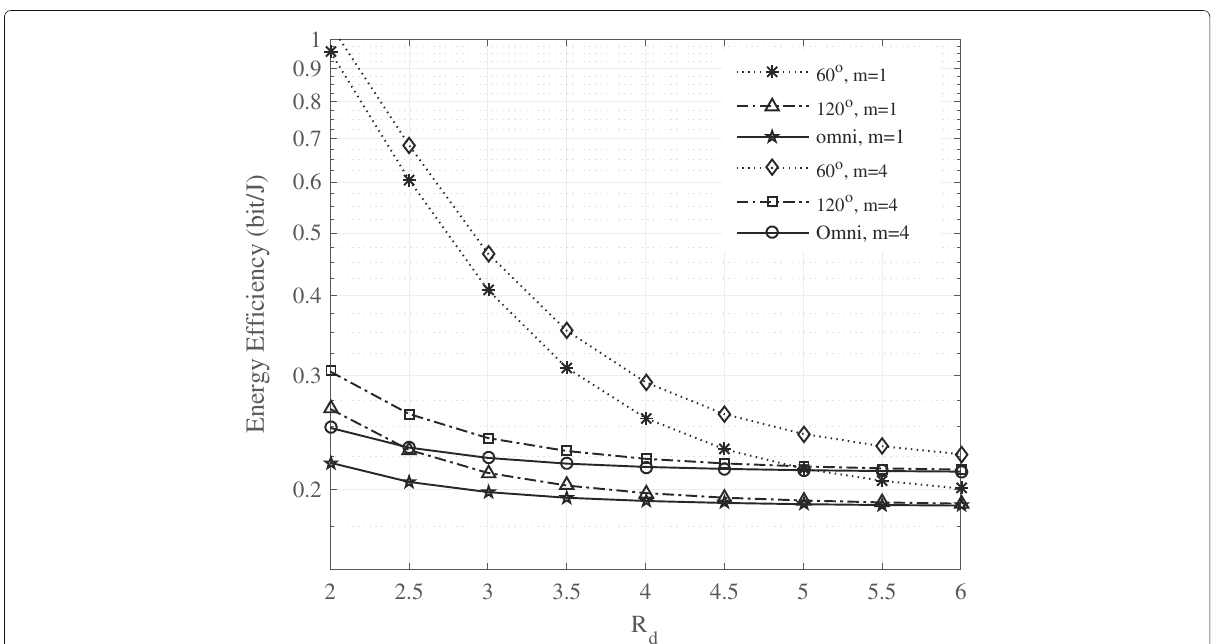
Fig. 7 Energy efficiency of cellular network for omni, 120 ◦ and 60 ◦ antenna configurations as a function of normalized reuse distance with fading figure, m = 1 and 4, SNR = 10 dB, and α = 4. EE of multi-cell network with omni antenna system for m = 1 and 4, EE of multi-cell network with 120 ◦ sectorized antenna system for m = 1 and 4, EE of multi-cell network with 60 ◦ sectorized antenna system for m = 1 and